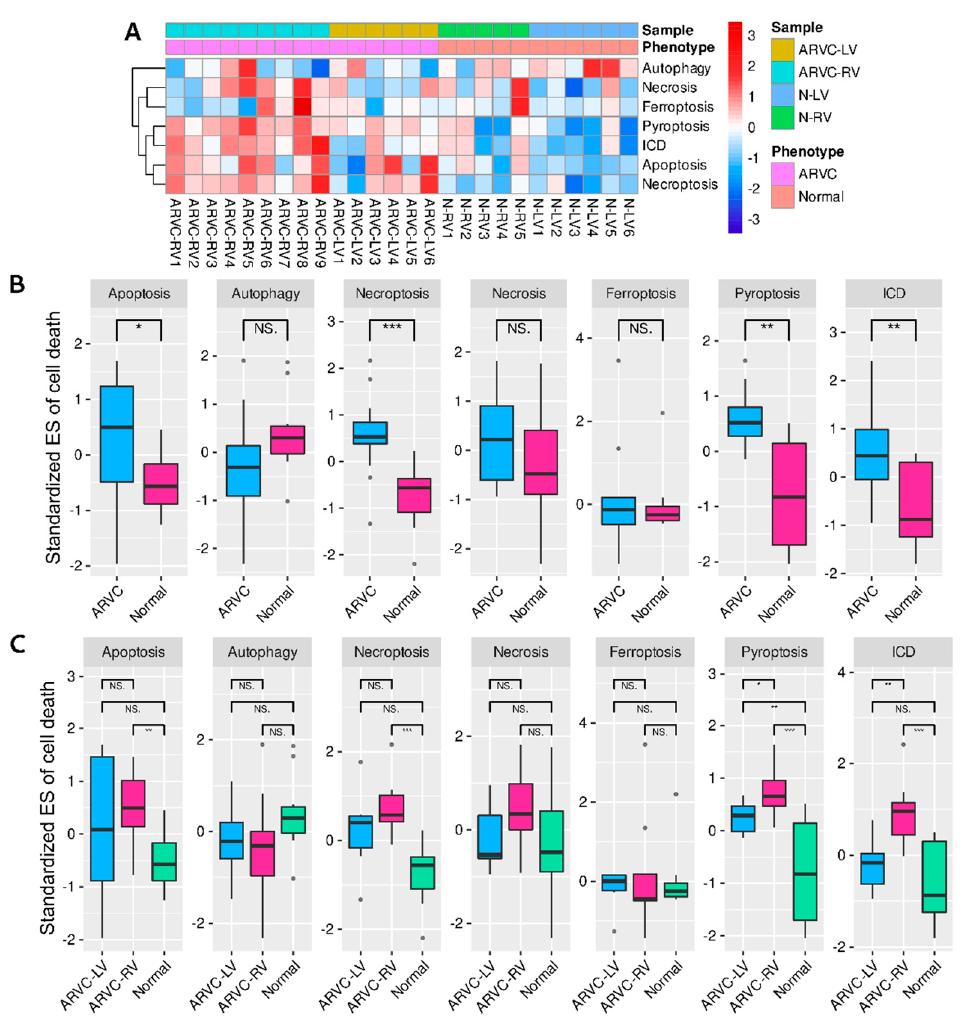
Figure 2. Single-sample gene-set enrichment analysis (ssGSEA) of cell death processes. ( A ): A heatmap shows the standardized enrichment scores (ES) of each sample. ( B ): Comparisons of the standardized cell death ESs between the ARVC and normal groups. ( C ): Comparisons of the standardized cell death Ess, among ARVC-LV, ARVC-RV, and normal controls. Abbreviations are the same as in Figure 1. *** p < 0.001; ** p < 0.01; * p < 0.05; NS, non-significance.